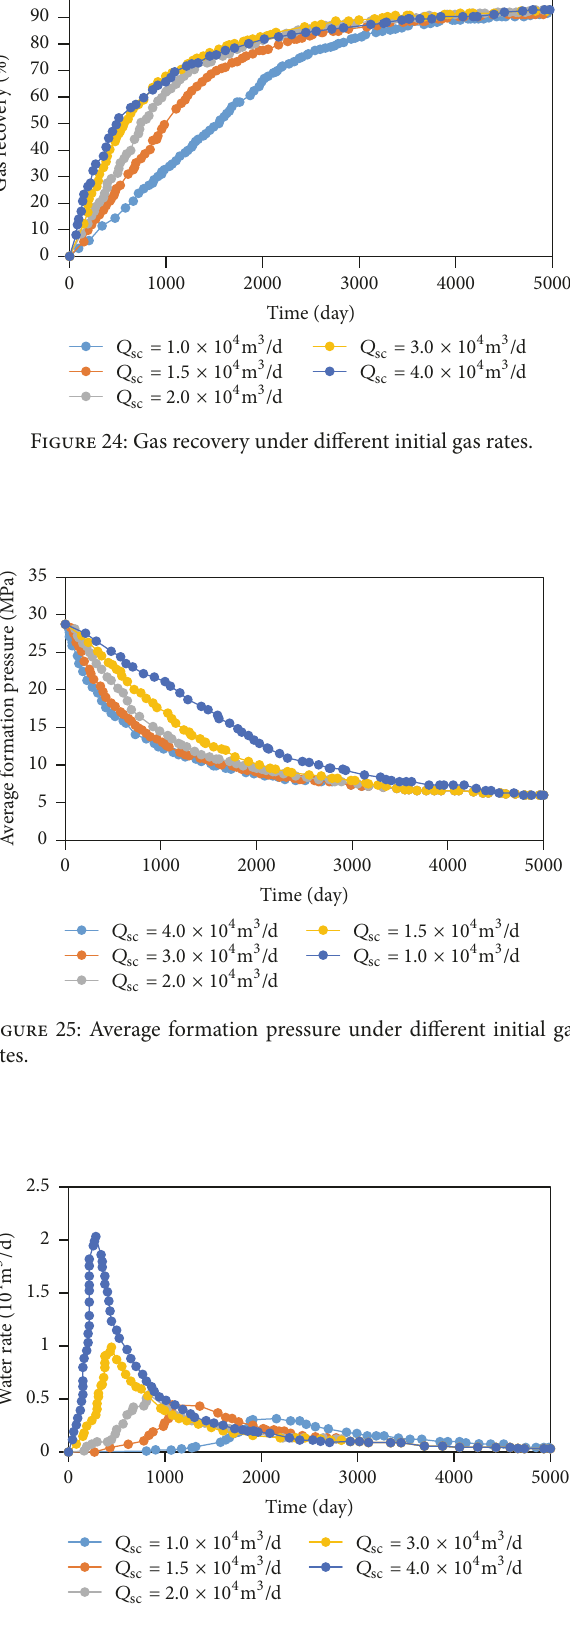
Figure 26: Water rate under different initial gas rates.